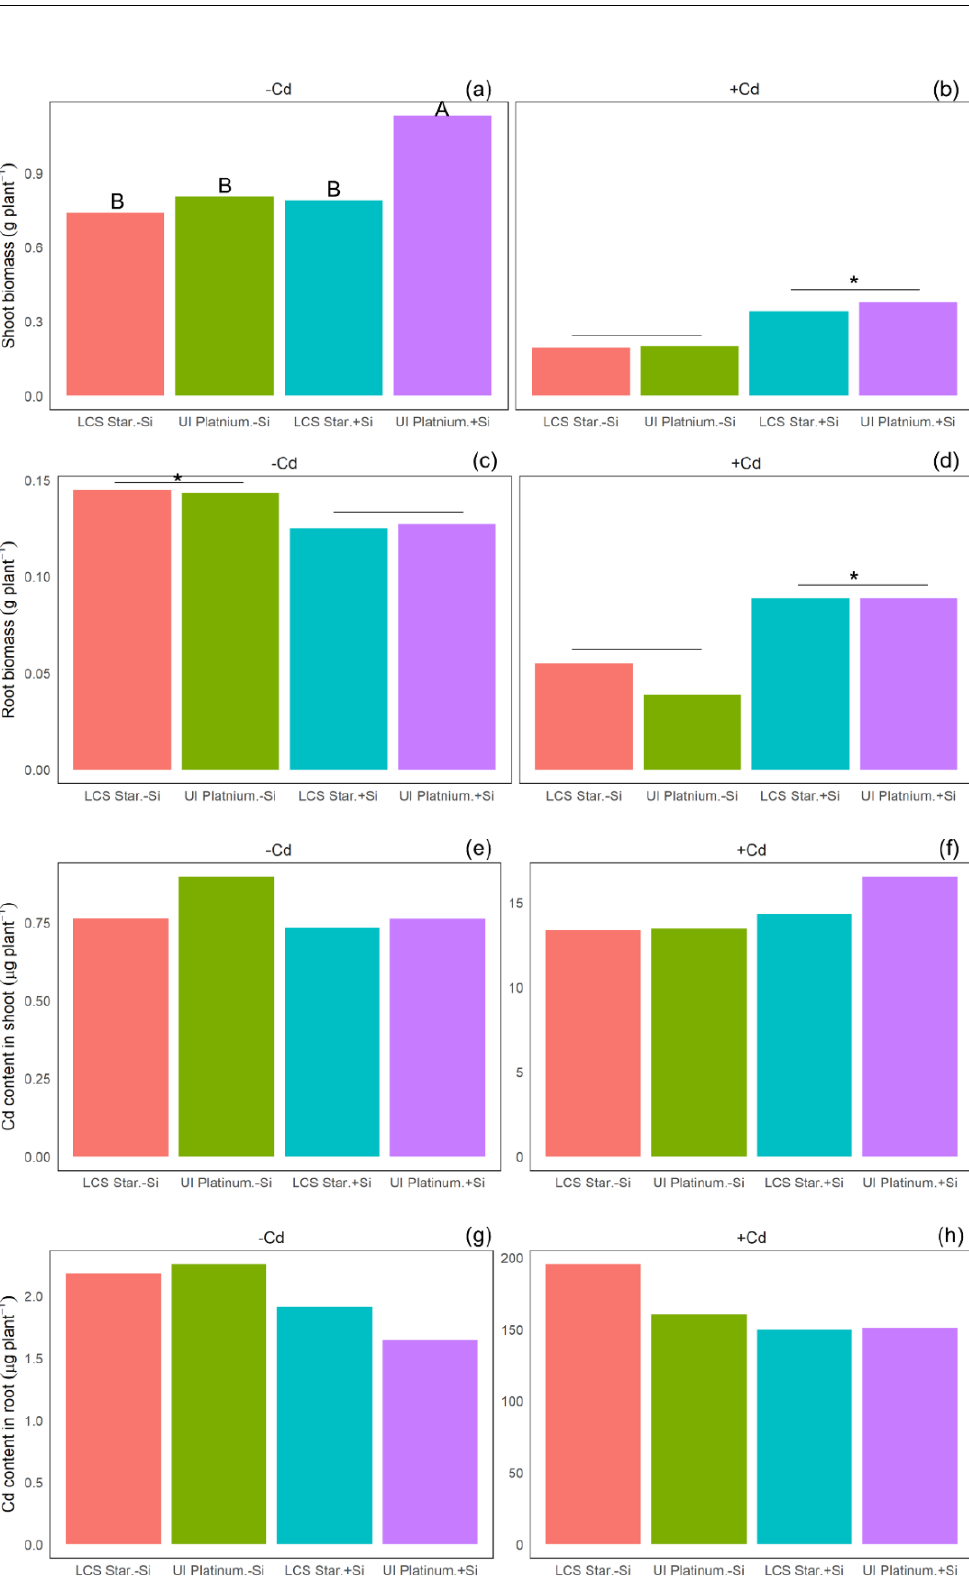
Figure 1. Shoot and root biomass ( a – d ) and Cd content ( e – h ) of LCS Star and UI Platinum in response to Si and Cd treatments. Cd content in shoot or root was not significantly different between wheat cultivars or Si treatments ( p > 0.05) ( e – h ). Different letters indicate significant differences in cultivar × Si level at α = 0.05. The symbol “*” indicates significant differences between Si levels at α = 0.05.